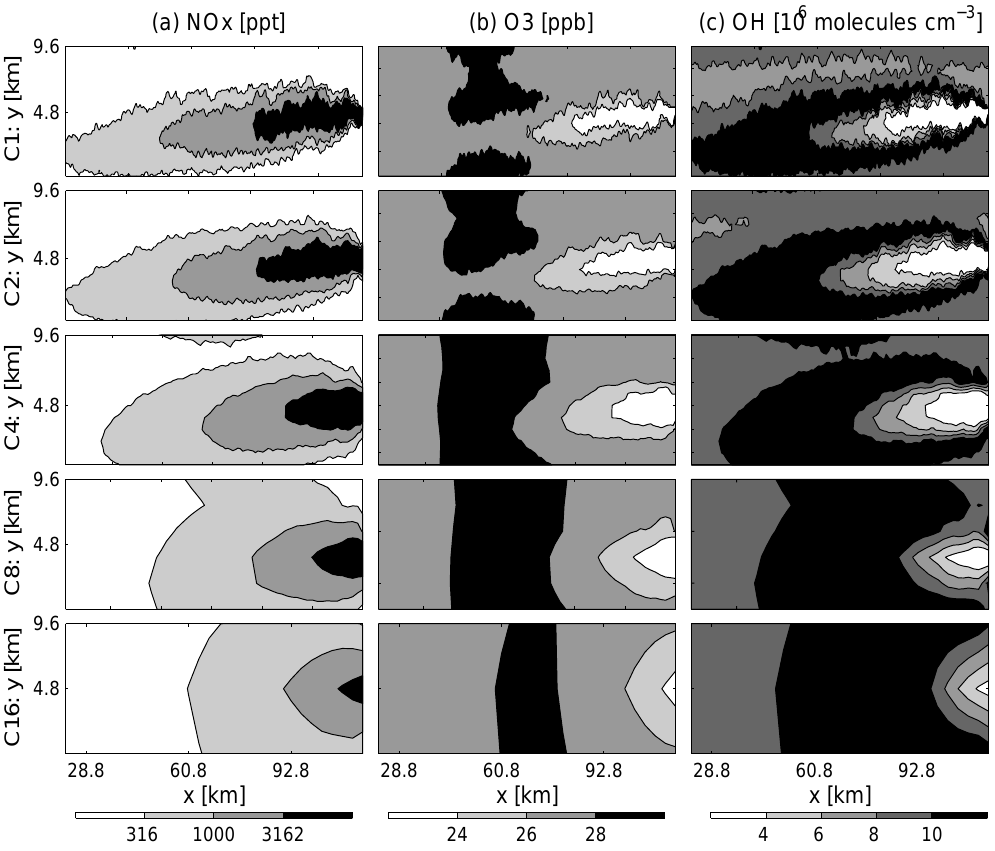
Fig. 3. Lowest vertical level of plume in NO x (a) , O 3 (b) and OH (c) at noon (local time) on day 2 for five different model resolutions. First row shows the highest resolution C1, then below C2, C4, C8 and C16.